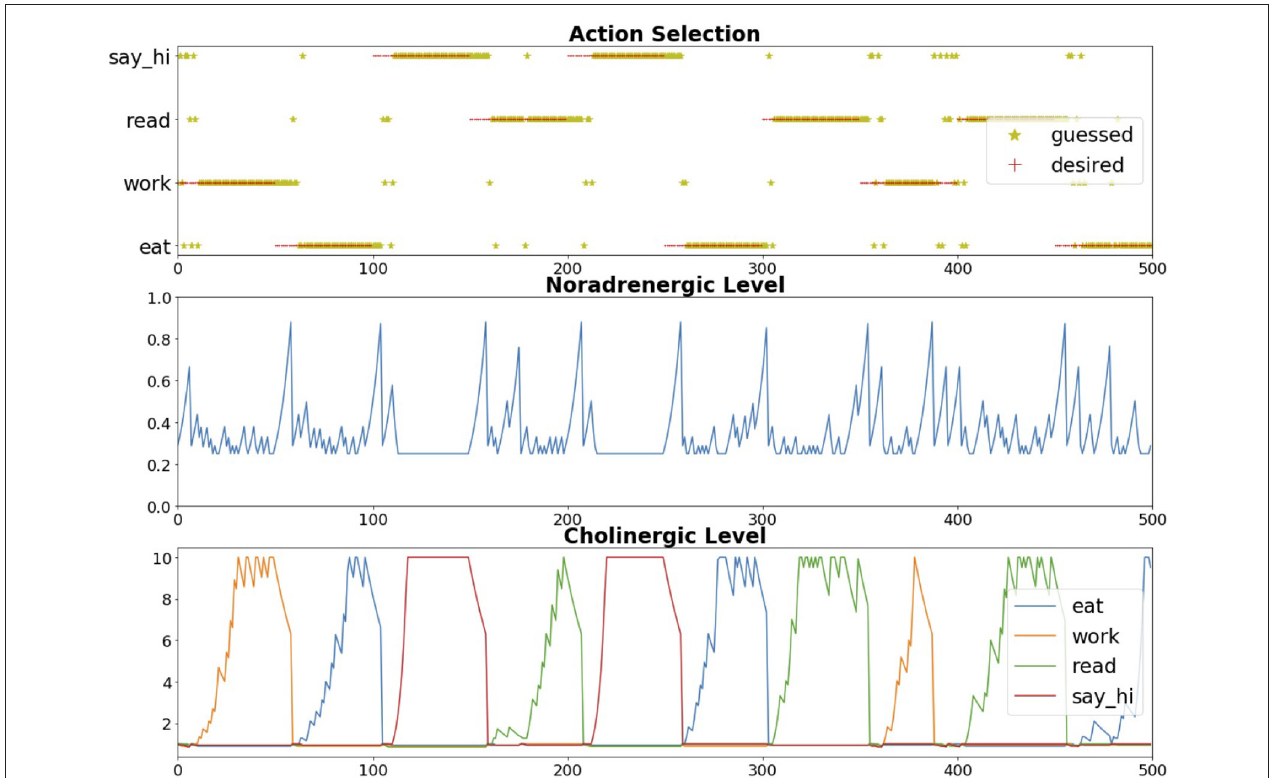
FIGURE 10 | Expected and unexpected uncertainty neuromodulation in neurorobot experiment. Top chart. Robot’s response to guess the user’s goal. Center chart. Noradrenergic (NE) neuron activity level. Bottom chart. Cholinergic (ACh) neuron activity level. There was an ACh neuron for each potential goal. Adapted from Zou et al.